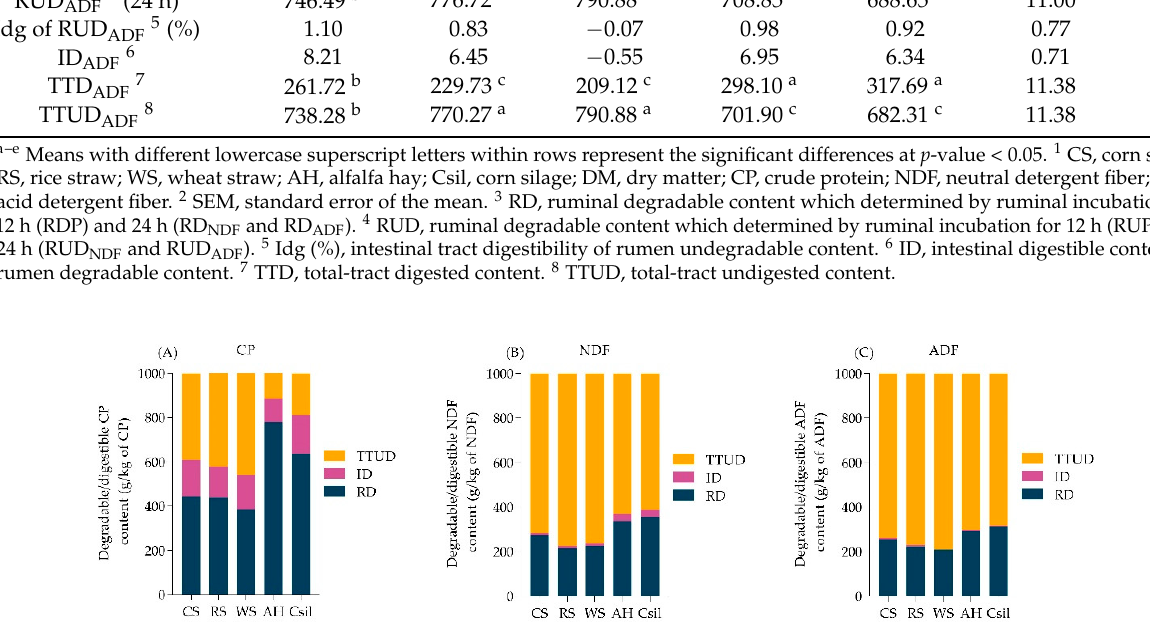
Table 4. The multiple linear regression equations for predicting iNDF 288 and total-tract digestibil-